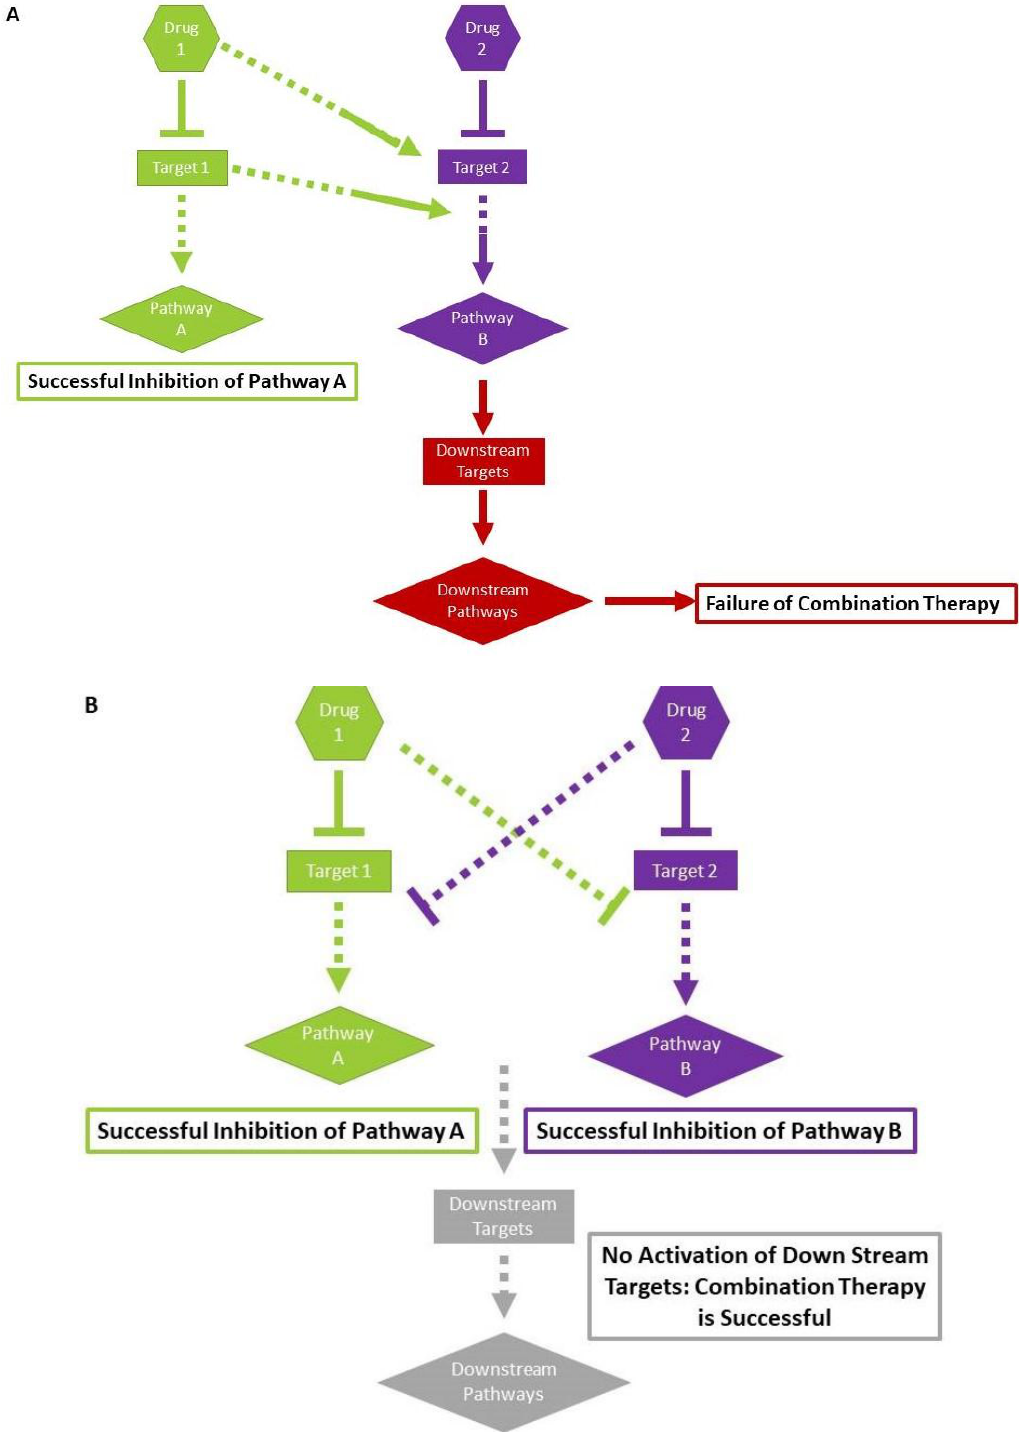
Figure 2. Cont. Figure 2.